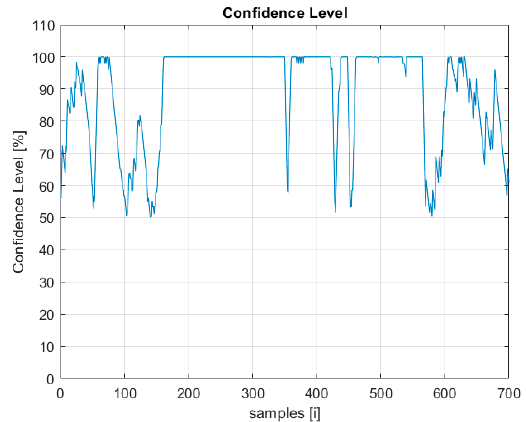
Figure 5. Radar detection confidence level plot.